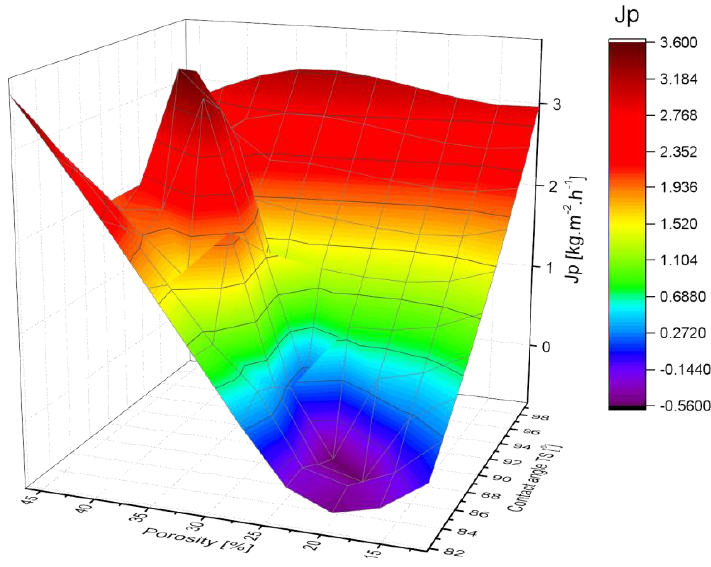
Figure 15. 3D graph of permeate vapor flux as a function of porosity and contact angle.